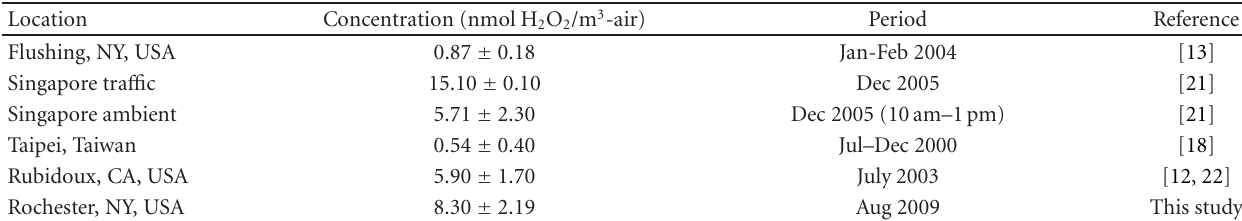
Table 4: Summary of previous particle-bound ROS